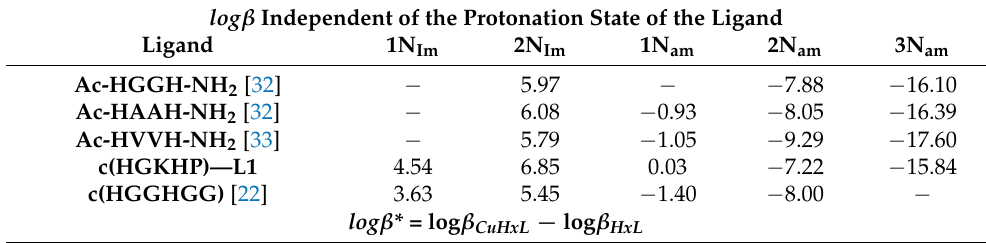
Table 2. Calculated value of log β * independent of the protonation state of the selected ligands. log β Independent of the Protonation State of the